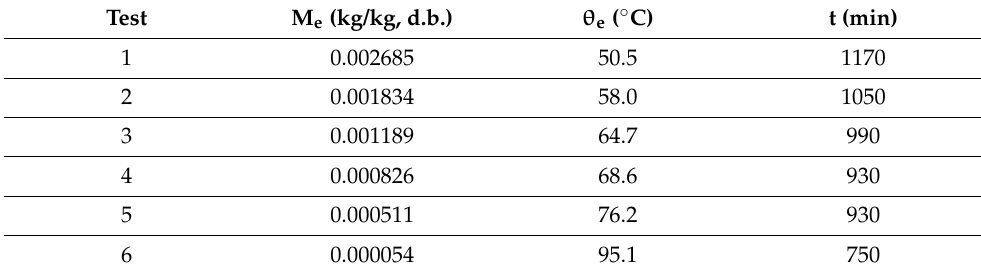
Table 4. Experimental parameters obtained after drying the ceramic block